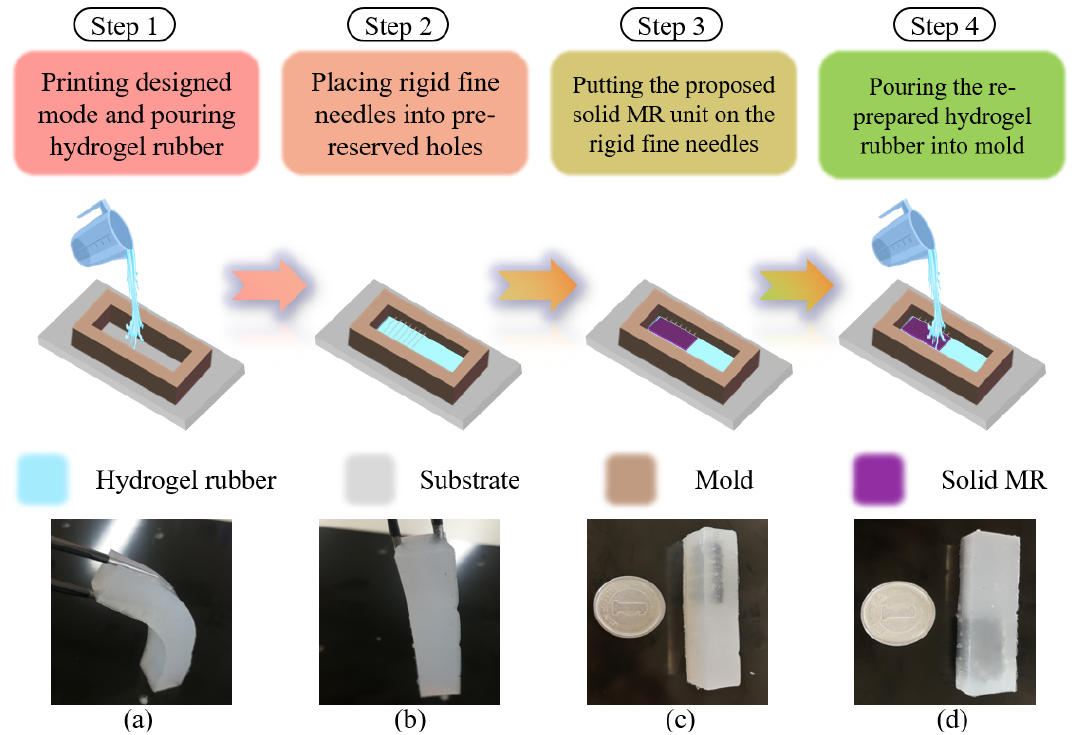
Figure 6. The molding process for magnetically controlled hydrogel (MCH): ( a ) bendability of hydrogel without MR unit; ( b ) self-healing of hydrogel without MR unit; ( c ) the side view of MCH; ( d ) the main view of MCH.